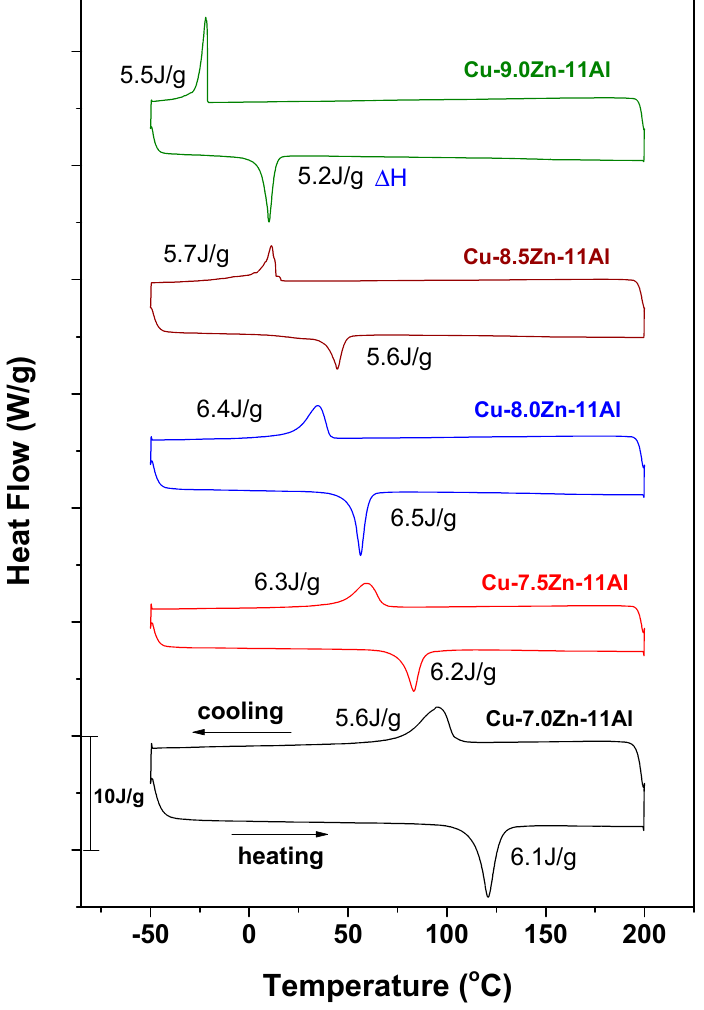
Figure 3. DSC curves for Cu-xZn-11Al SMAs with various Zn contents.